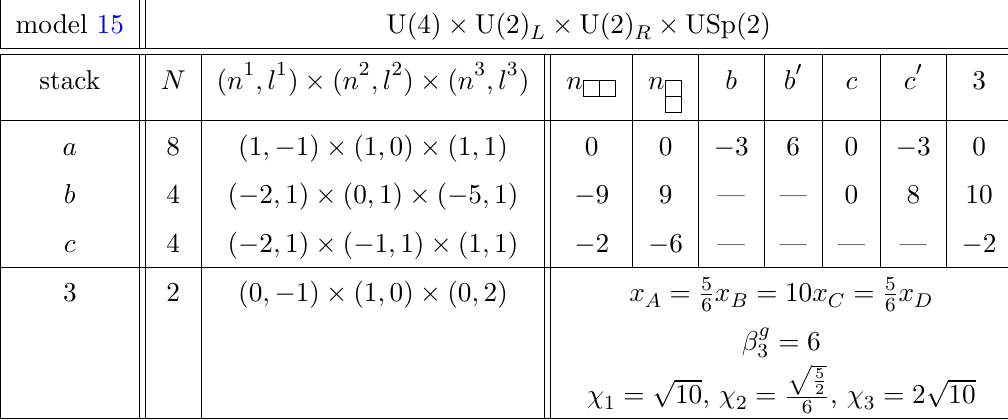
Table 15 . D6-brane configurations and intersection numbers of Model 15, and its MSSM gauge